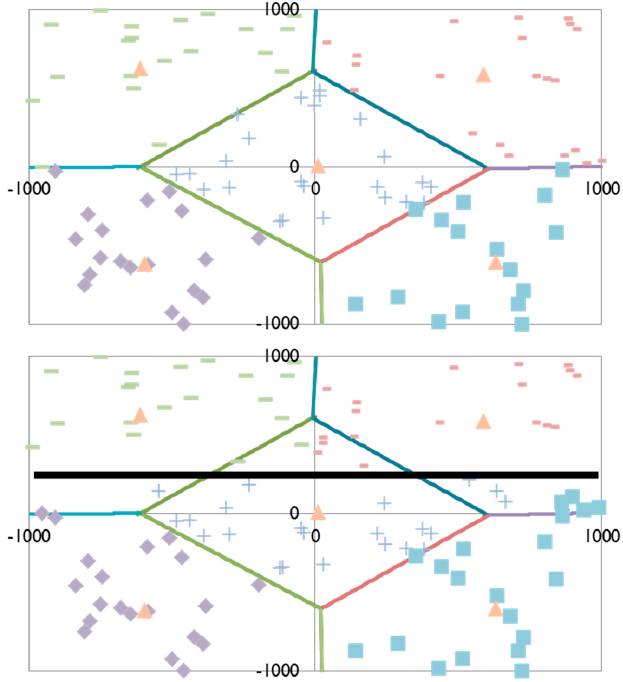
Figure 2. Adaptability of the auction-based cluster formation technique in response to signal blockage.